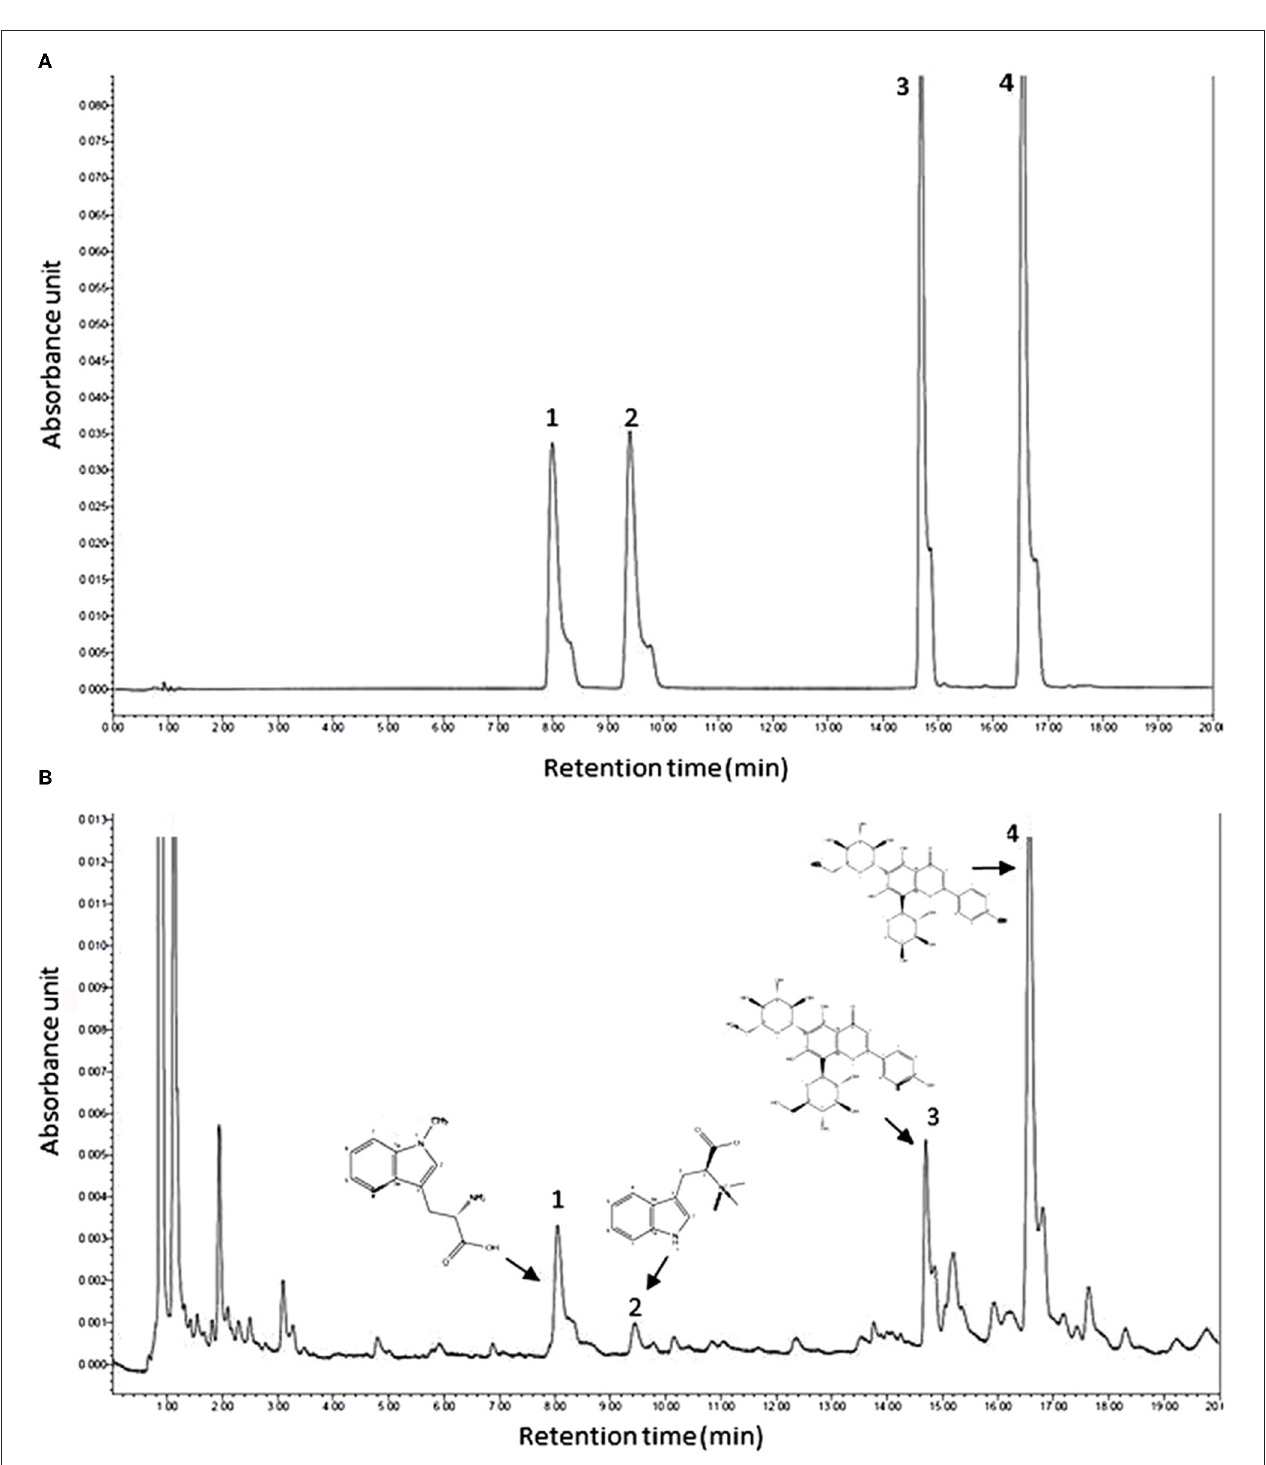
FIGURE 1 | Typical ultra-high performance liquid chromatography chromatograms of mixed reference substances (A) and ACD (B) . ACD, Abrus cantoniensis Hance decoction; 1, abrine; 2, hypaphorine; 3, vicenin-2; 4, schaftoside.